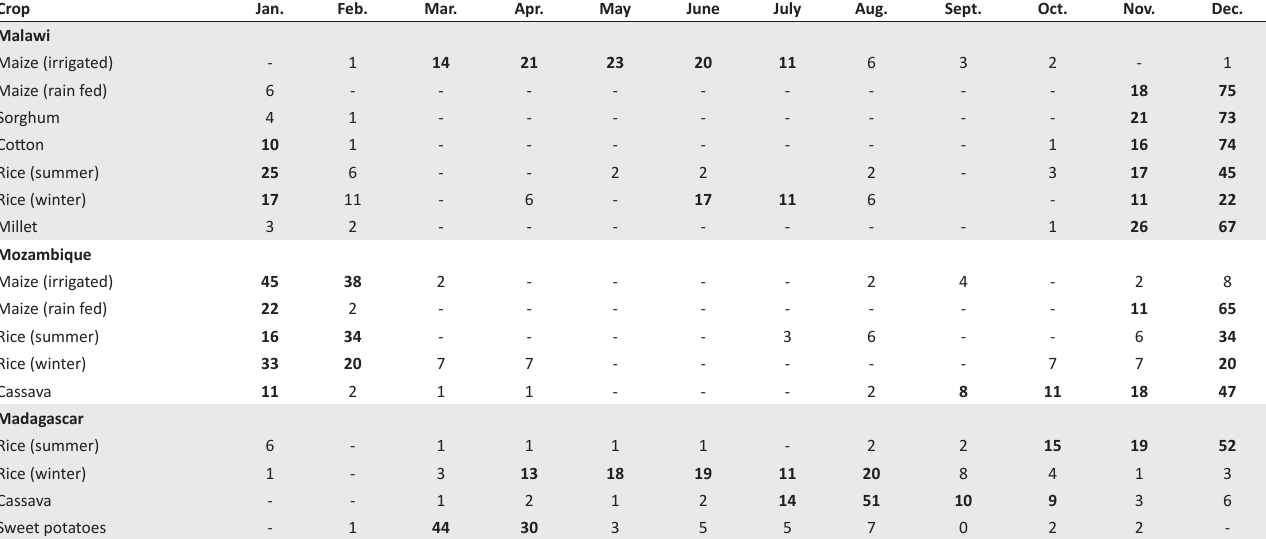
FIGURE 3: Occurrence of hazards likely to occur in Madagascar according to month. FIGURE 4: Occurrence of hazards likely to occur in Mozambique according to TABLE 1: Planting times (percentage of respondents).